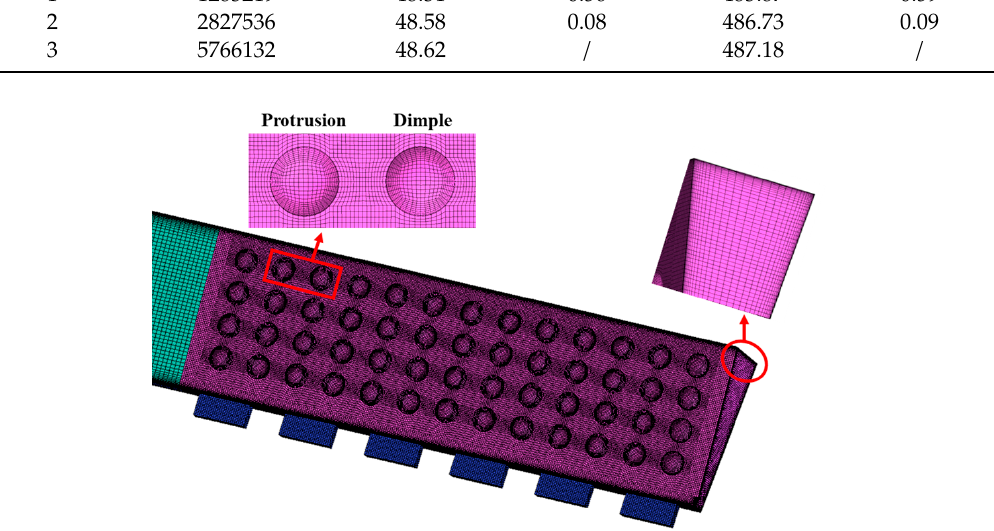
Table 2. Grid dependence study with dimple-protrusion case, Re = 10,000.